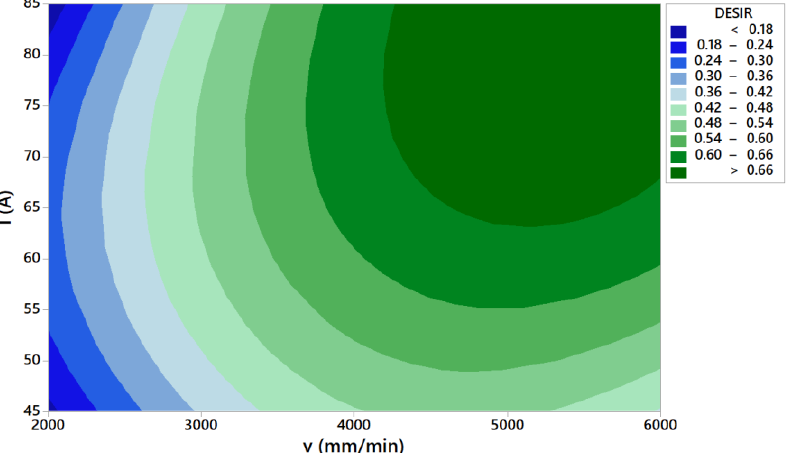
Figure 17. Desirability contour plot for multi-objective optimization Wu - α - Ra - Rz - MRR at H = 1 mm.